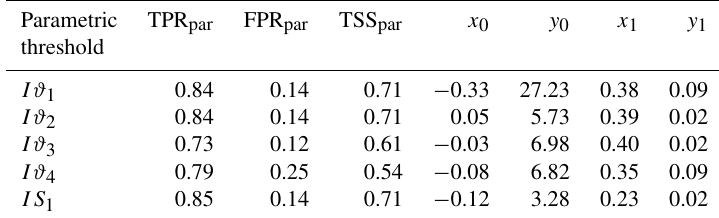
Table 3. TSS values in correspondence with each analyzed scenario and parameters ( x 0 , y 0 , x 1 , y 1 ) estimated for the parametric thresholds.